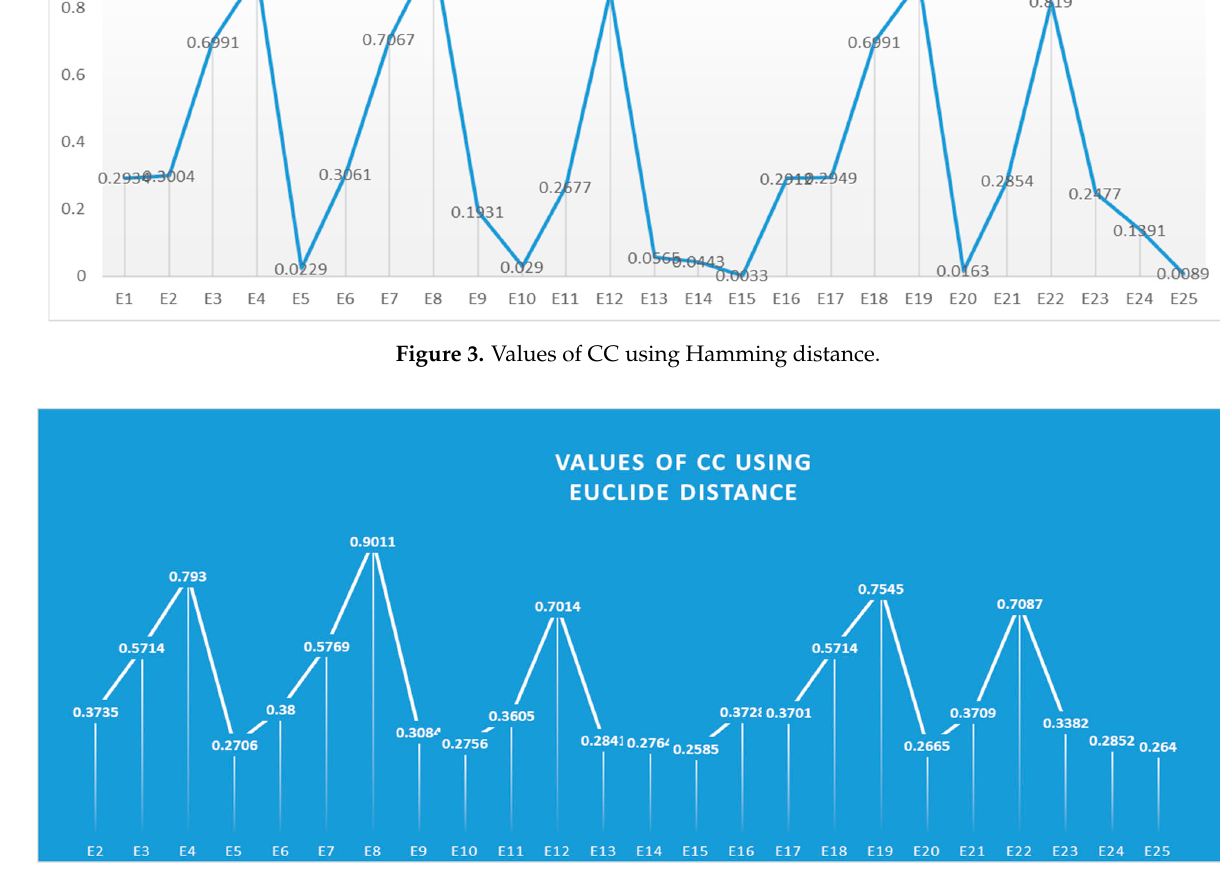
Figure 4. Values of CC using Euclidean distance.